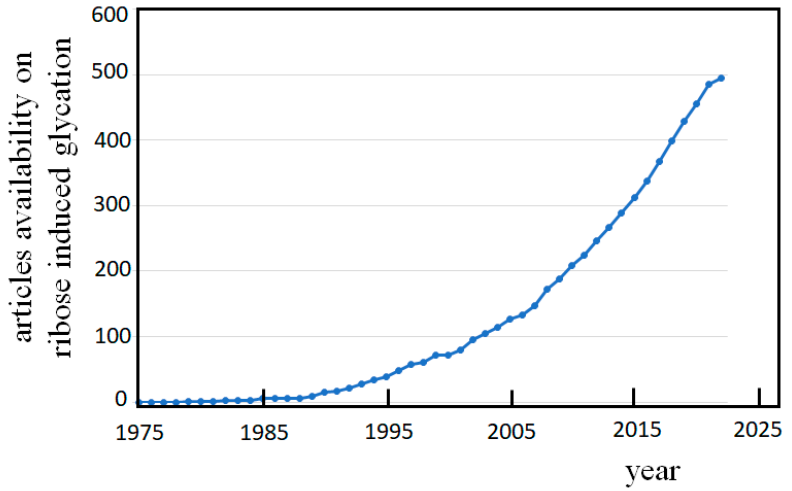
Figure 4. Articles availability along the past forty years. Numbers emerge from the PubMed ® data base, searching for: “glycation and ribose” on August 2022.